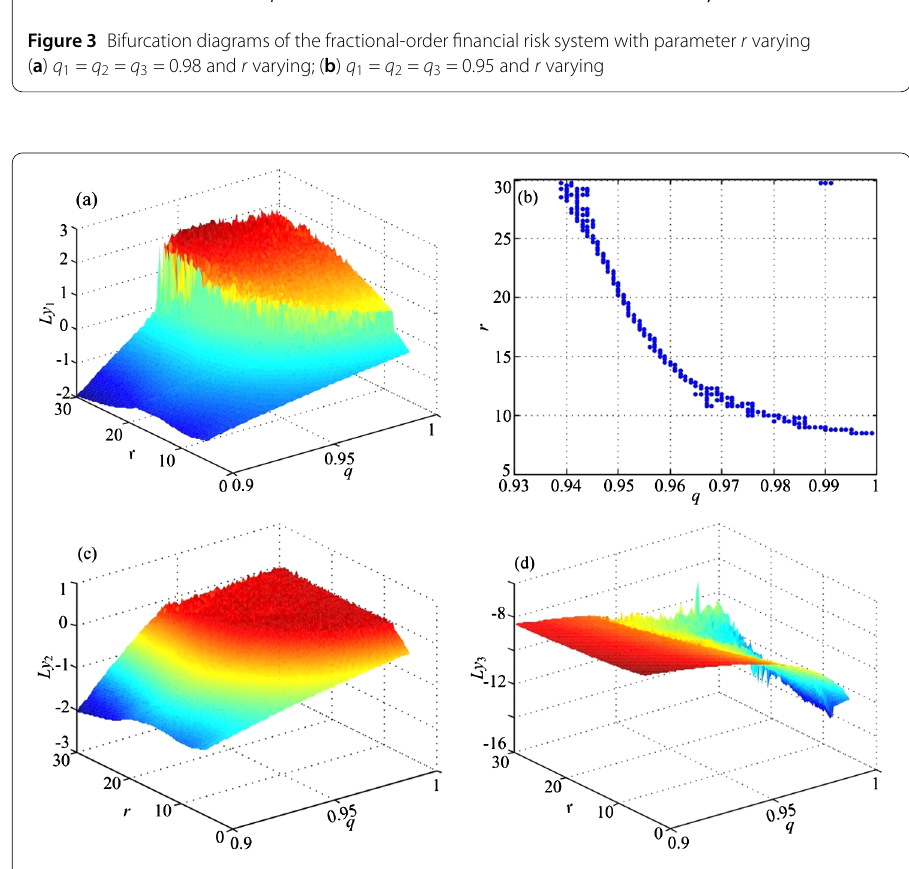
Figure 4 q – r plane of the fractional-order financial risk system ( a ) LEs 1, r , q plane, ( b ) r , q plane, ( c ) LEs 2, r , q plane, and ( d ) LEs 3, r , q plane